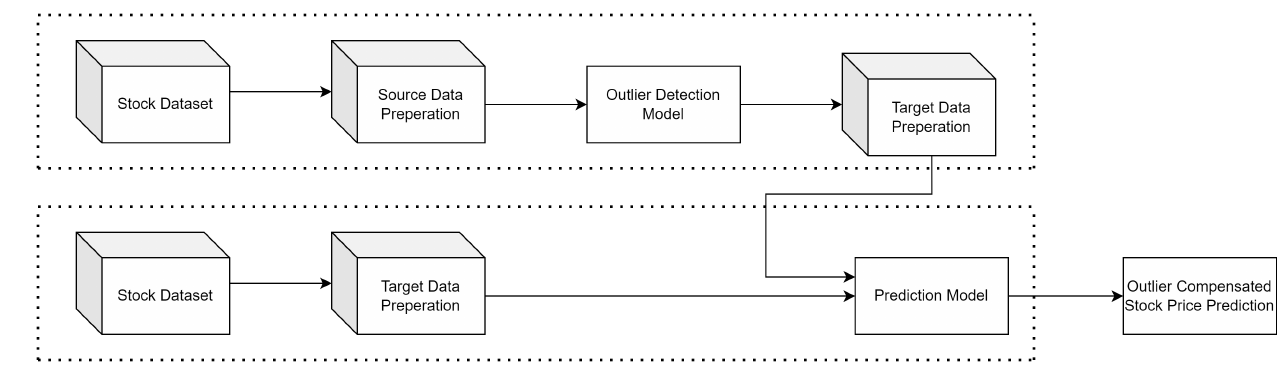
Figure 2. Information transfer diagram of the proposed